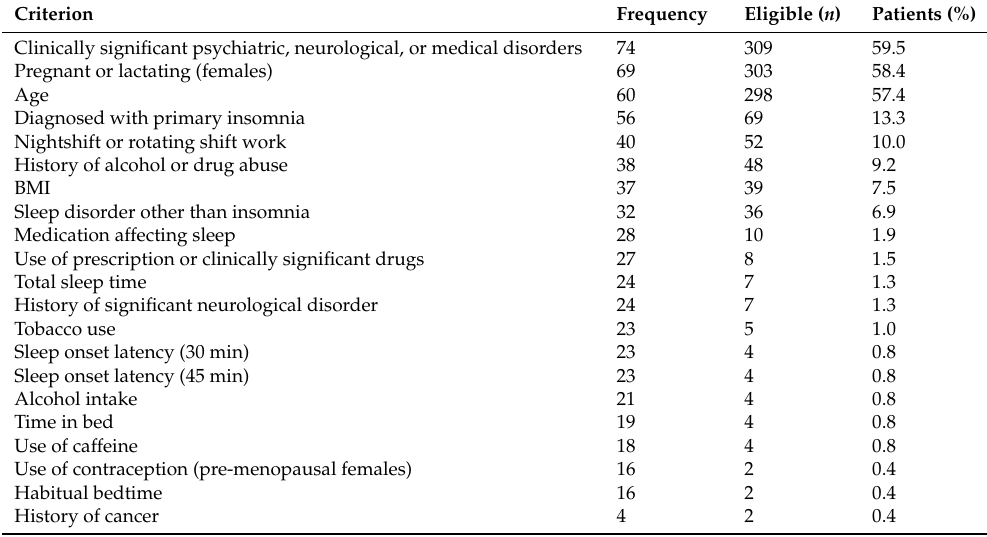
Table 3. Percentage of eligible patients after applying subsequent eligibility criteria ( n +